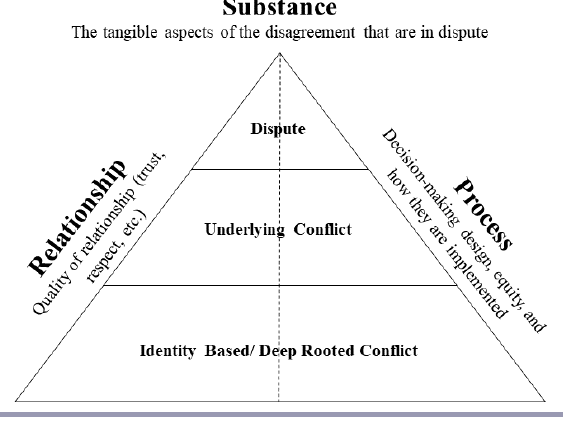
Fig. 1 . The conceptual framework for analyzing how three dimensions of conflict, i.e., substance, relationship, and process, contribute to the conflict at hand, some of which is often hidden in deeper levels of conflict. Both relationships and process can influence conflict at each level, indicated by the dashed line. Central to conflict analysis is to identify which dimensions are neglected and how management can target them more effectively. Adapted from Madden and McQuinn